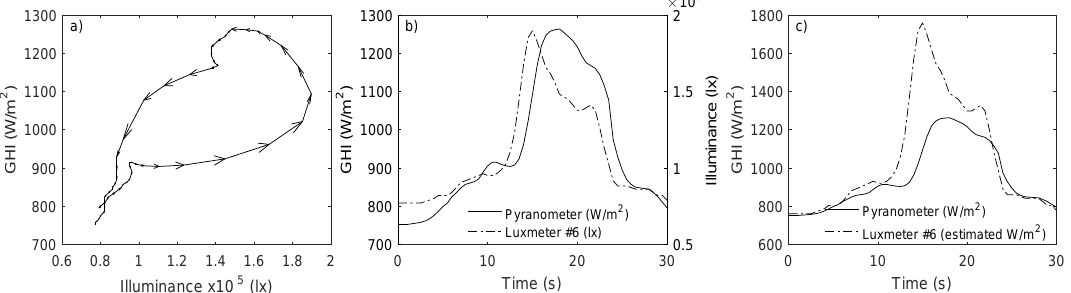
Figure 4. Analysis of the pyranometer and lux-meter #6 performances during a cloud enhancement event: trajectory in the scatter plot ( a ); comparison of measured illuminance and irradiance in the time domain ( b ); and comparison of estimated and measured irradiance in the time domain ( c